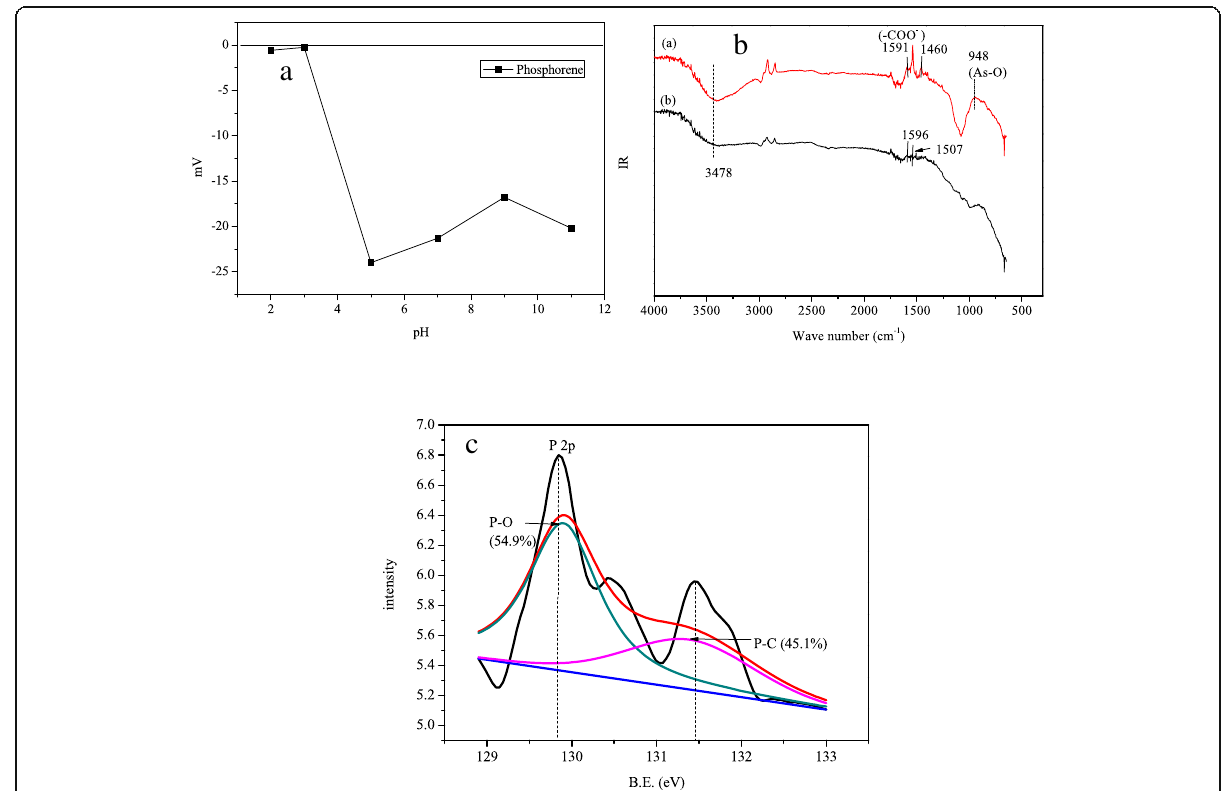
Fig. 3 Phosphorene characterization ( a ) zeta potential of phosphorene and graphene oxide, ( b ) FTIR of phosphorene (black curve: before As(III)